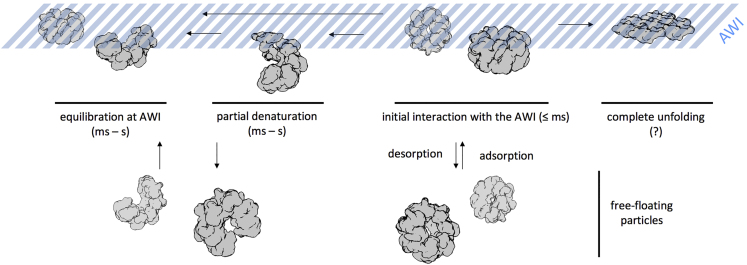
Proposed Model of Protein-AWI InteractionsThe initial interaction with the AWI (adsorption) is fast. Equilibration of the protein-AWI system, however, is slower as it involves processes such as desorption, partial, or complete denaturation, which occur on various timescales (milliseconds to seconds) and are thought to be highly protein dependent (desorption from the AWI, rate of unfolding).